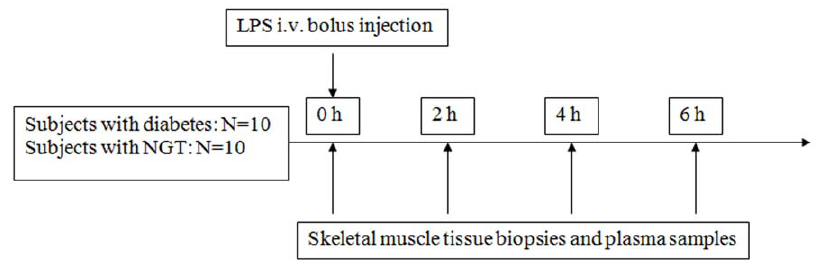
Figure 1. Schematic overview of the study design. Fig. 1 10 patients with diabetes and 10 volunteers with NGT were included in the study. After obtaining skeletal muscle biopsies and plasma samples at baseline (0 h), subjects received an intravenous bolus injection of LPS, 0.3 ng/kg. Muscle tissues biopsies and plasma samples were also obtained at 2, 4 and 6 hours after LPS. NGT: Normal glucose tolerance, LPS: lipopolysaccharide.